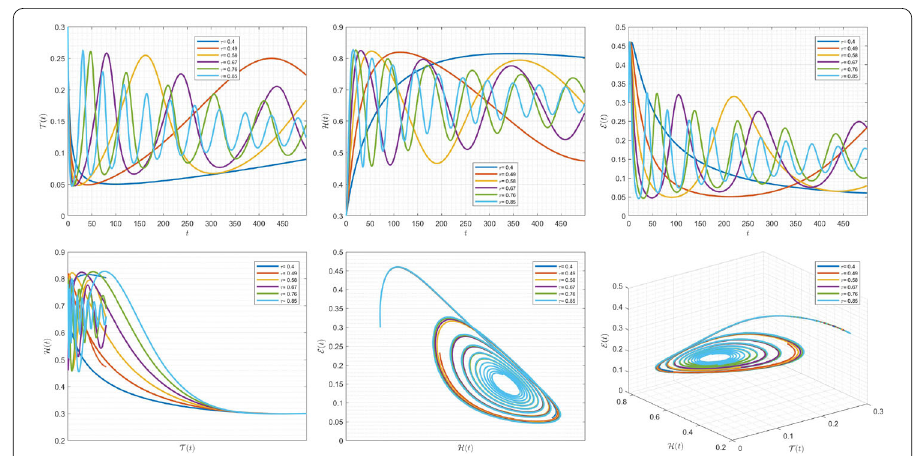
Figure 11 Simulations for solving (60) using (65) along with ( T (0), H (0), E (0)) = (0.3,0.3,0.3) and β 12 = 0.745